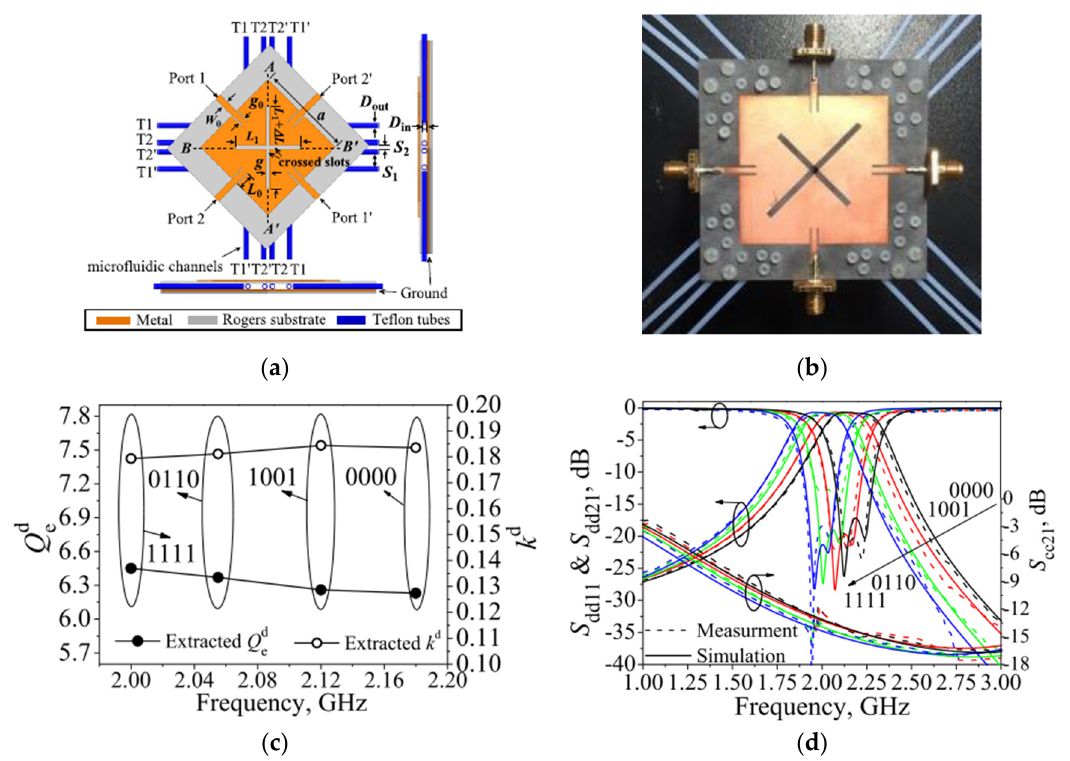
Figure 8. The proposed reconfigurable balanced BPF [35]: ( a ) Structure layout; ( b ) Prototype Figure8. TheproposedreconfigurablebalancedBPF[35]: ( a )Structurelayout; ( b )Prototypephotograph; photograph; ( c ) External quality factors and coupling coefficients; ( d ) Simulated and measured ( c ) External quality factors and coupling coe ffi cients; ( d ) Simulated and measured tunable tunable s-parameters. Table 1. Performance comparisons for some recent single-band differential microstrip BPFs. Ref.